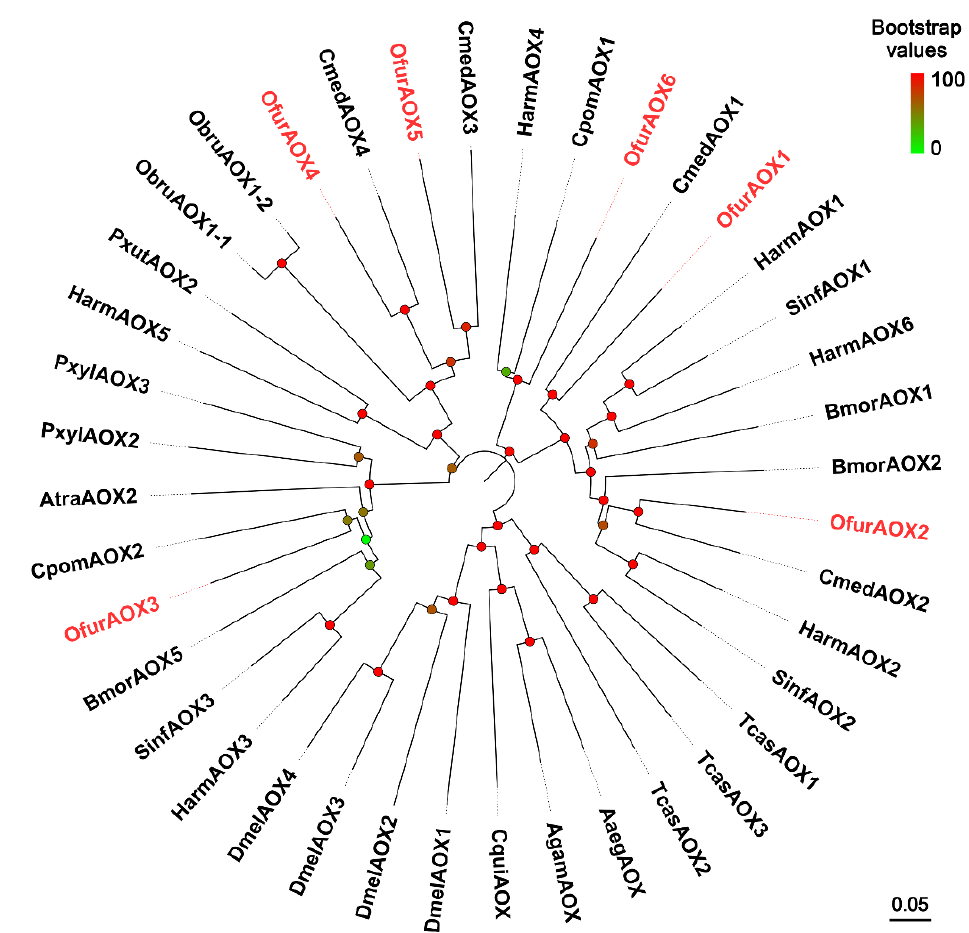
Figure 6. Phylogenetic analysis of AOXs from Ostrinia furnacalis (Ofur-prefix), Helicoverpa armigera (Harm), Cnaphalocrocis medinalis (Cmed), Amyelois transitella (Atra), Bombyx mori (Bmor), Sesamia inferens (Sinf), Cydia pomonella (Cpom), Plutella xylostella (Pxyl), Papilio xuthus (Pxut), Operophtera brumata (Obru), Culex quinquefasciatus (Cqui), Aedes aegypti (Aaeg), Anopheles gambiae (Agam), Drosophila melanogaster (Dmel), and Tribolium castaneum (Tcas). Bootstrap values are indicated by coloring from green (0) to red (100). The O. furnacalis AOXs are colored red. AOX sequences used in this analysis are listed in Table S1.